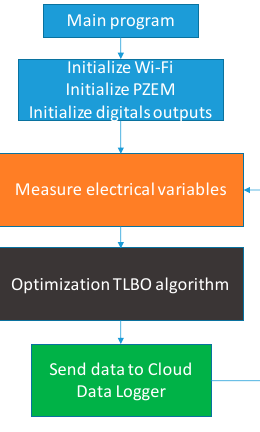
Figure 4. PFCSM main program.